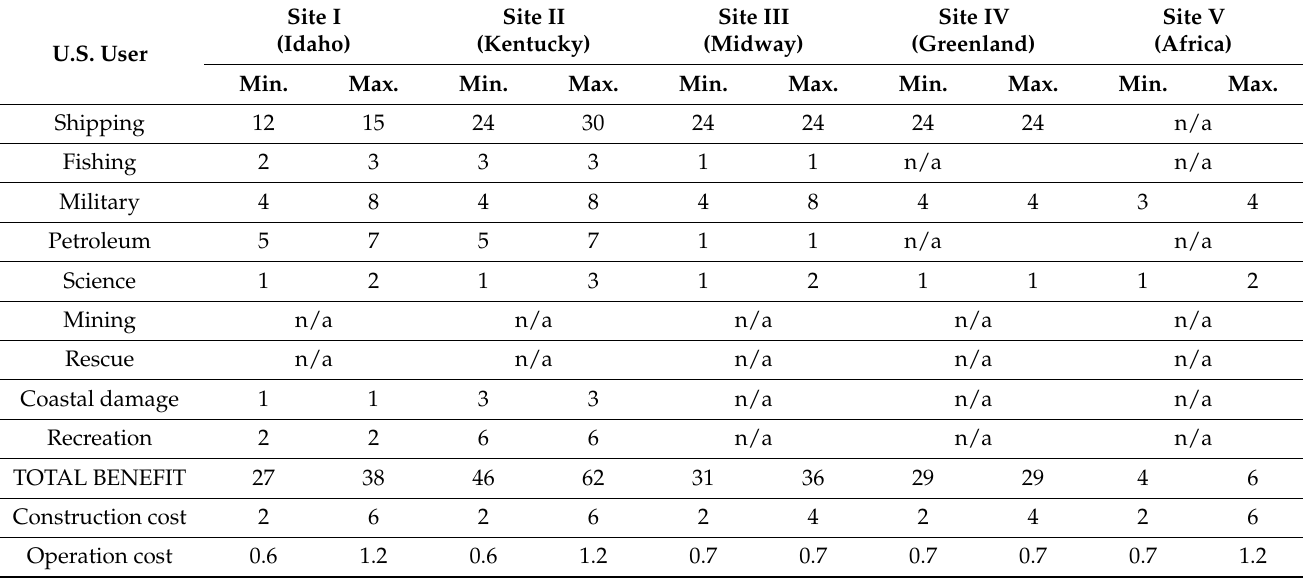
Table 3. Benefit and cost summary